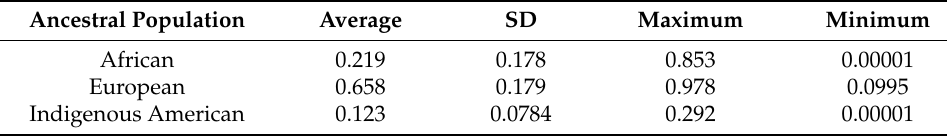
Figure 4. Visualization of the ancestry proportions for each individual in 49 PR H/L men with PCa (Puerto Rico PCa) compared to 1000 Genomes Admixed Americans populations. Assuming three ancestral populations ( k = 3), each column represents one individual, and each color corresponds to the contribution of each ancestral population to the genome of a given individual (blue = African, yellow = European, and red = Indigenous American). Table 2. Ancestry proportions in the study cohort ( n =